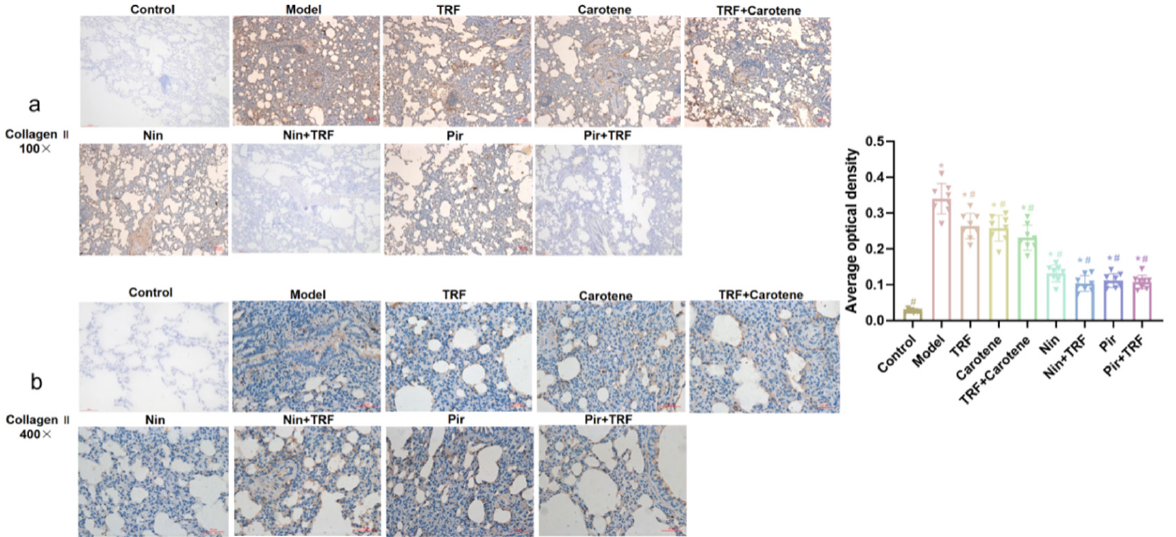
Figure 7. Amelioration of bleomycin-induced PF: Lungs from different rat groups were collected, and 5- µ m thick sections were prepared and used for the assessment of tissue injury; representative images of IHC staining for collagen I in the lungs: ( a ) original magnification: 100 × ; ( b ) original magnification: 400 × ; n = 8. Note: * represents p < 0.05 in comparison to the control group; # represents p < 0.05 in comparison to the model group.